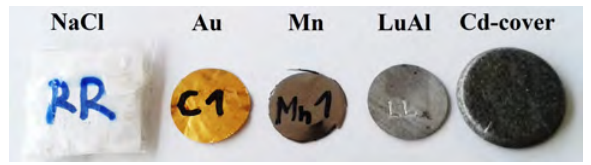
Figure 4. Set of activation detectors.